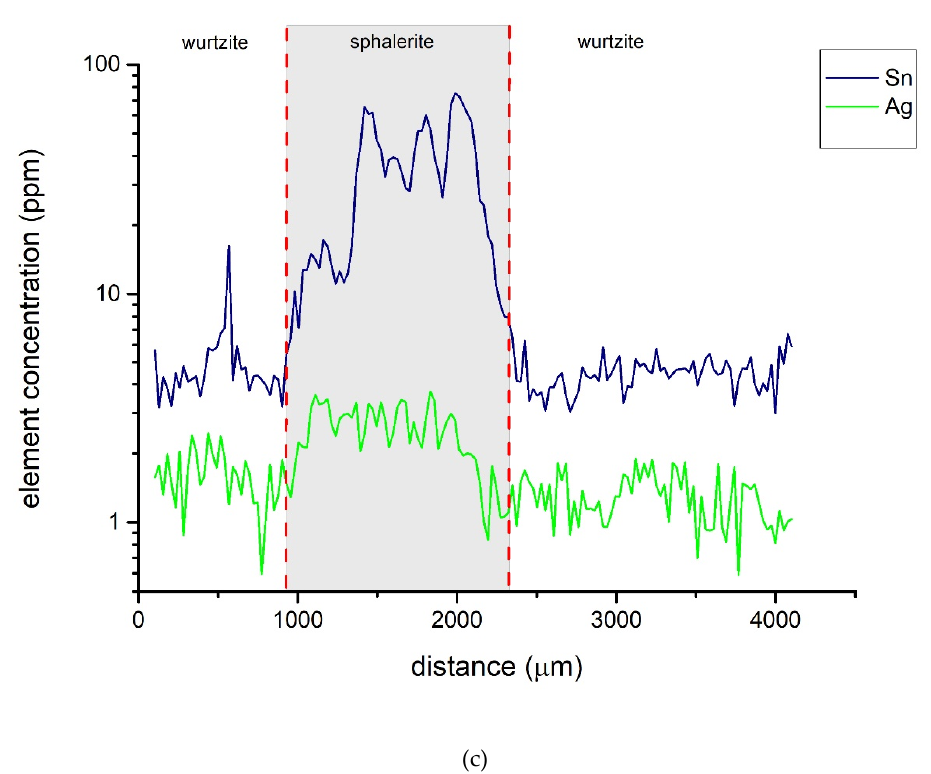
Figure 5. LA-ICP-MS line scans showing the distribution of minor and trace elements between the wurtzite and sphalerite regions of the Merelani sample. ( a ) Plot of minor and trace elements along Line scan 1. ( b ) Plot showing the coupling between Cu and Ga in the Merelani sample. ( c ) Plot showing the lack of coupling between the concentrations of Sn and Ag in the Merelani sample. Note that trace element levels are elevated in the sphalerite region.